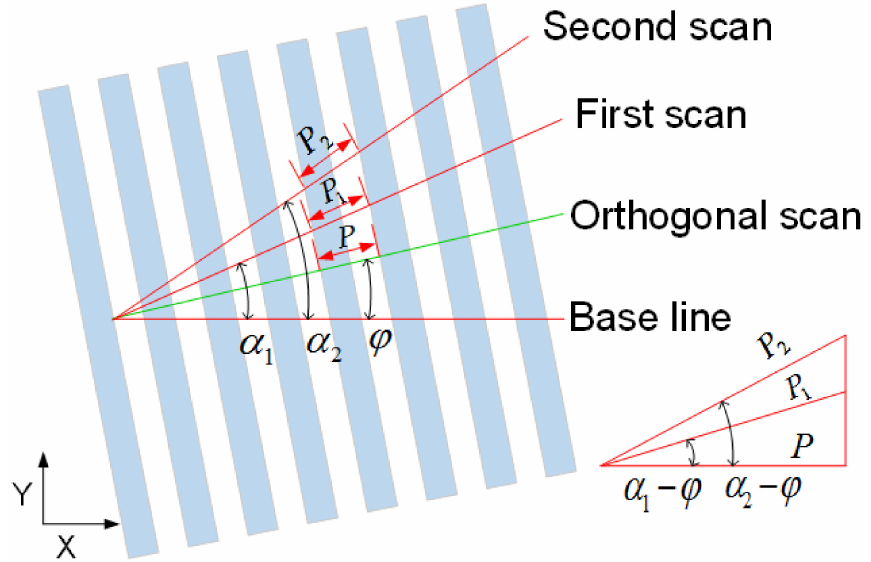
Figure 13. Illustration of the scan